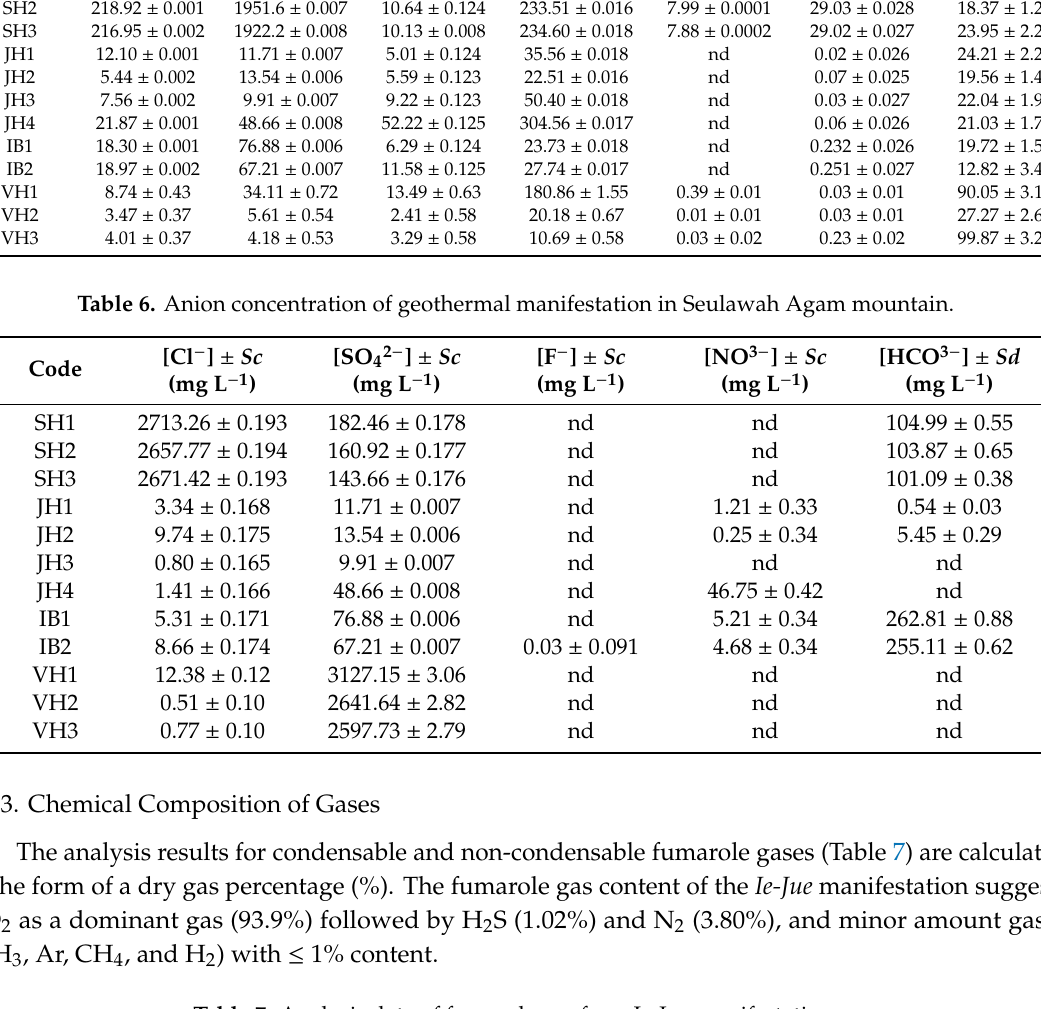
Table 7. Analysis data of fumarole gas from Ie-Jue